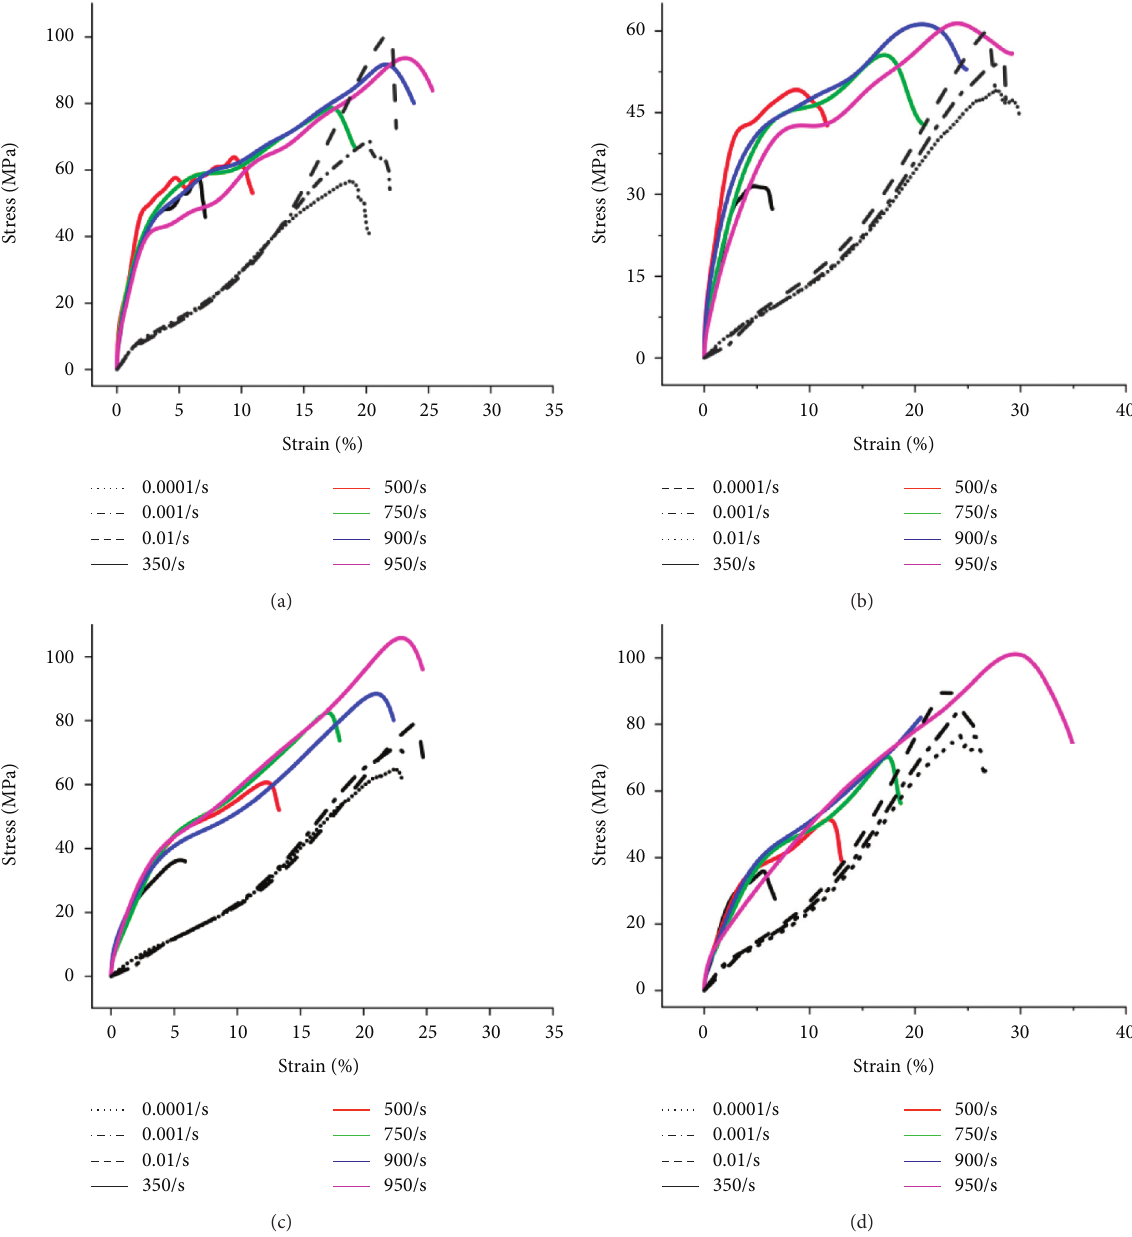
Figure 6: The stress-strain curves in different strain rates. (a) Warp direction of XYD. (b) Weft direction of XYD. (c) Warp direction of Ferrari. (d) Weft direction of